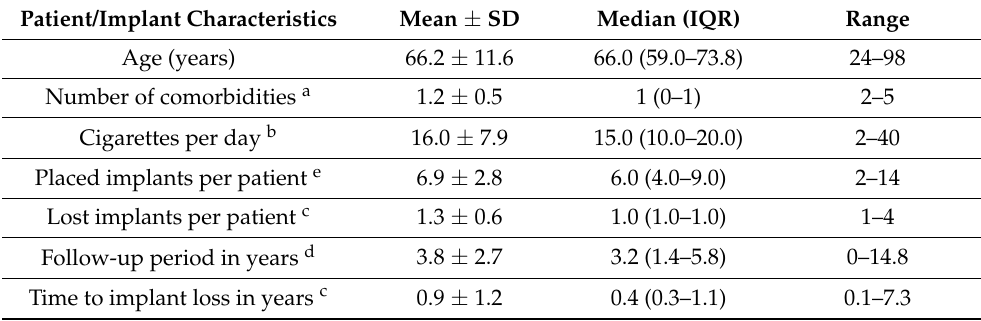
Table 1. Average characteristics of the study population. Abbreviations: SD, standard deviation; IQR, interquartile range. Note: a values relate to the cohort with a diagnosed systemic health condition ( n = 373), b values relate to the smoking cohort ( n = 208), c values relate to the cohort of patients that lost one or more implants ( n = 111), d value corresponds to the implant level ( n = 6047), e value includes any replacement implants for the lost implants.